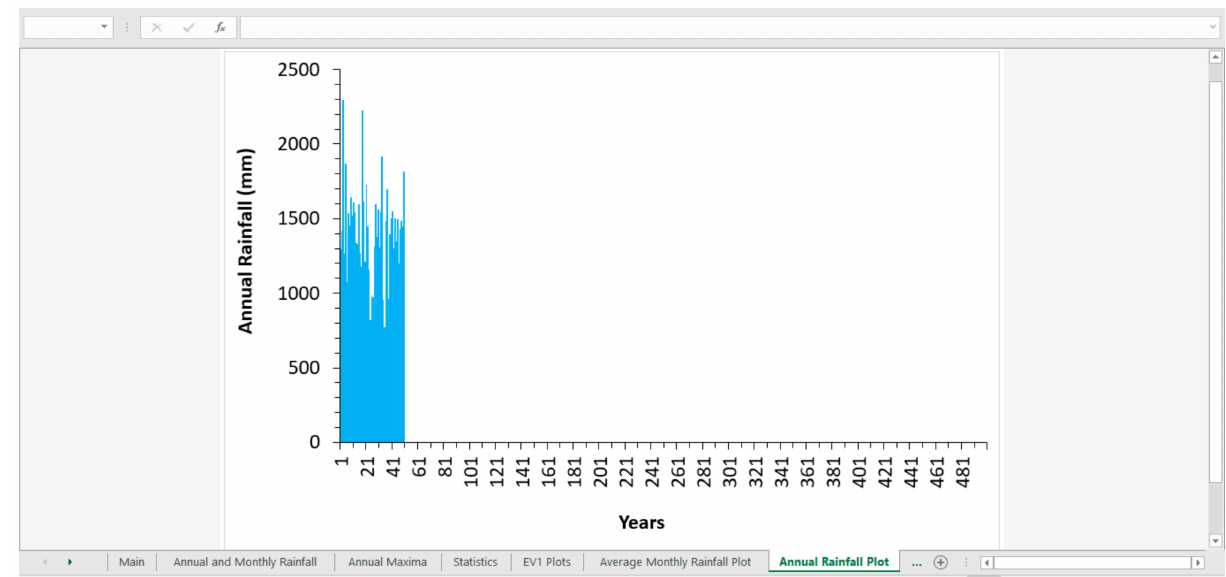
Figure 10. During the run, the user can control the progress of generation by analyzing the histogram for Annual Rainfall.